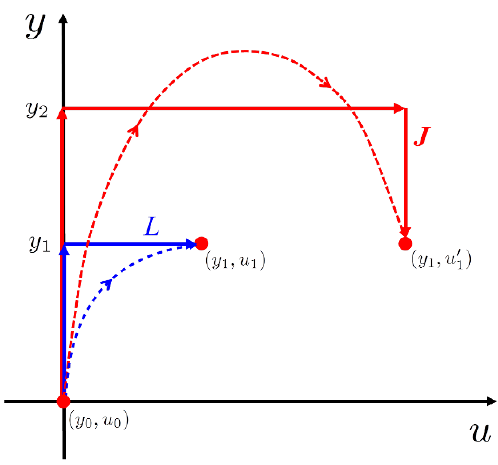
Figure 7 . An illustration of the two types of geodesics arising with F 1 metric. The L-shaped (blue) paths move in two straight segements to the target state, while the J-shaped (red) paths have three straight segments. The (cid:12)rst overshoots y 1 because motion in the u direction is less costly at higher values of y . The dashed curves illustrate the corresponding simple geodesics found with the F 2 measure, as in section